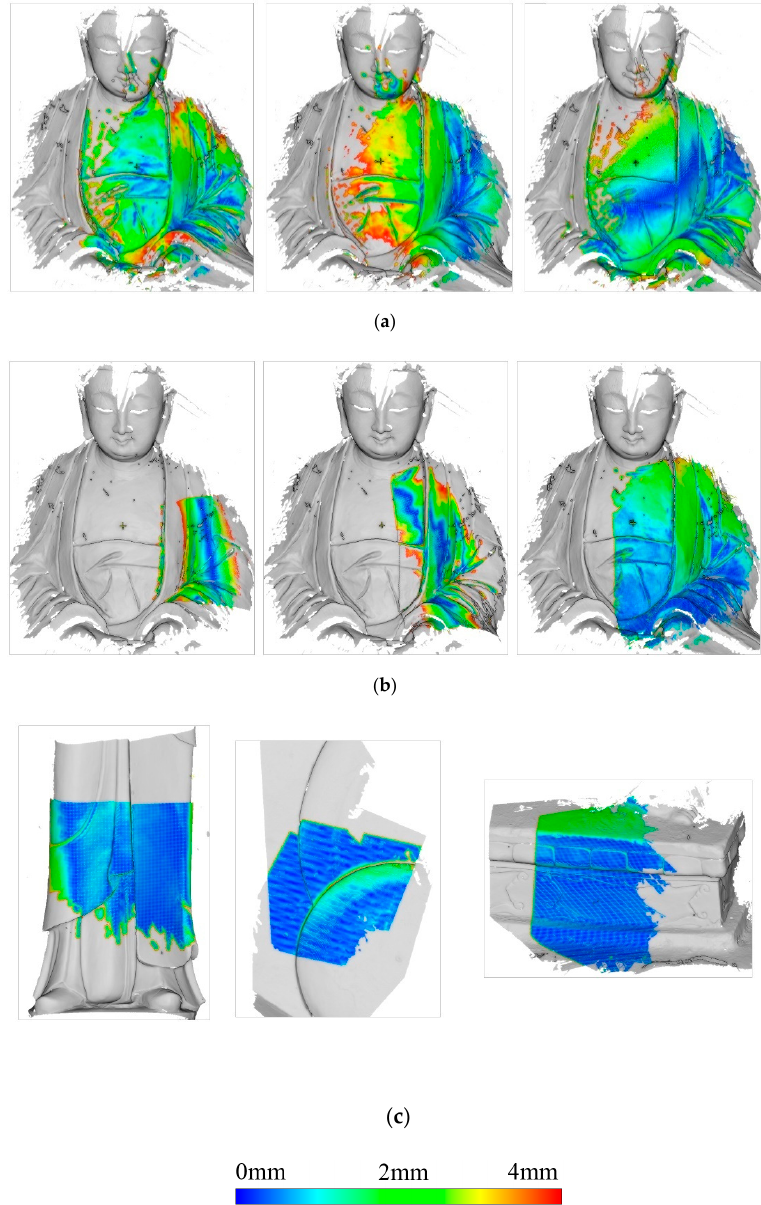
Figure 15. Evaluation of the robustness performance. ( a ) different noise; ( b ) different overlaps; ( c ) objects with few curves.